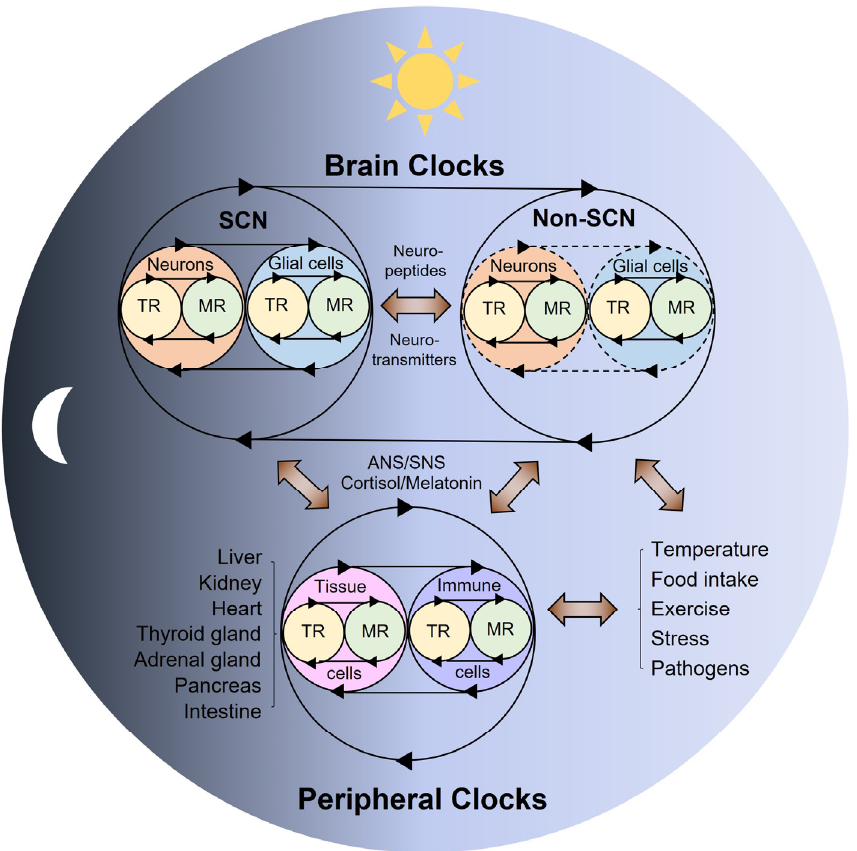
Figure 2. Coupled-tissue oscillators. Reciprocal crosstalk between the brain and peripheral clocks. The coupled TR and MR oscillators are thought to be commonly present across all body cells. Neurons and glial cells (e.g., astrocytes, microglia) interact to form the SCN central clock and non-SCN clocks in the brain. These autonomous brain clocks communicate with each other via neurotransmitters or neuropeptides, and with multiple peripheral tissue clocks via systemic innervations (ANS/SNS) or hormonal signals (e.g., cortisol, melatonin) in response to light–dark cycles. On the other hand, peripheral organs possess tissue autonomous clocks that can respond to non-photic physiological and environmental cues (e.g., temperature, food intake, exercise, stress) and provide feedback that influences the brain clocks via immune, metabolic, and endocrine signals. TR—transcriptional rhythms; MR—metabolic rhythms; ANS—autonomic nervous system; SNS—sympathetic nervous system.